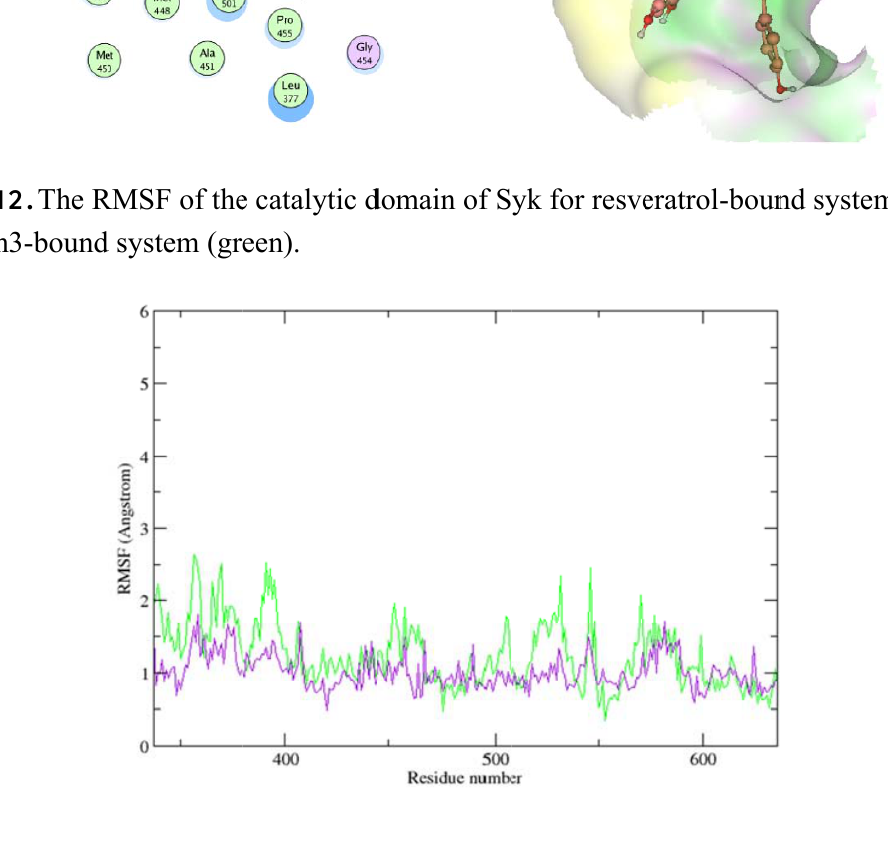
MD simul (grlation time vs. root m Smean-squar resvee one atoms f for resveratr rol–Syk sys stem.